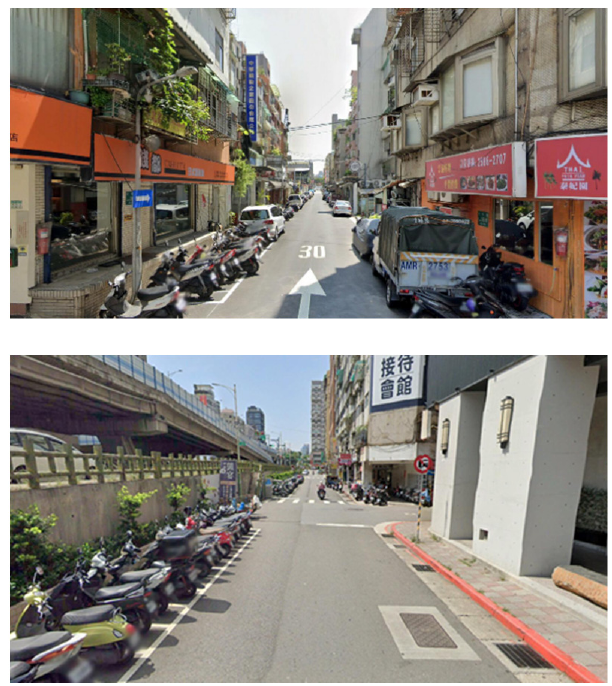
Figure 4. Environments of field test.